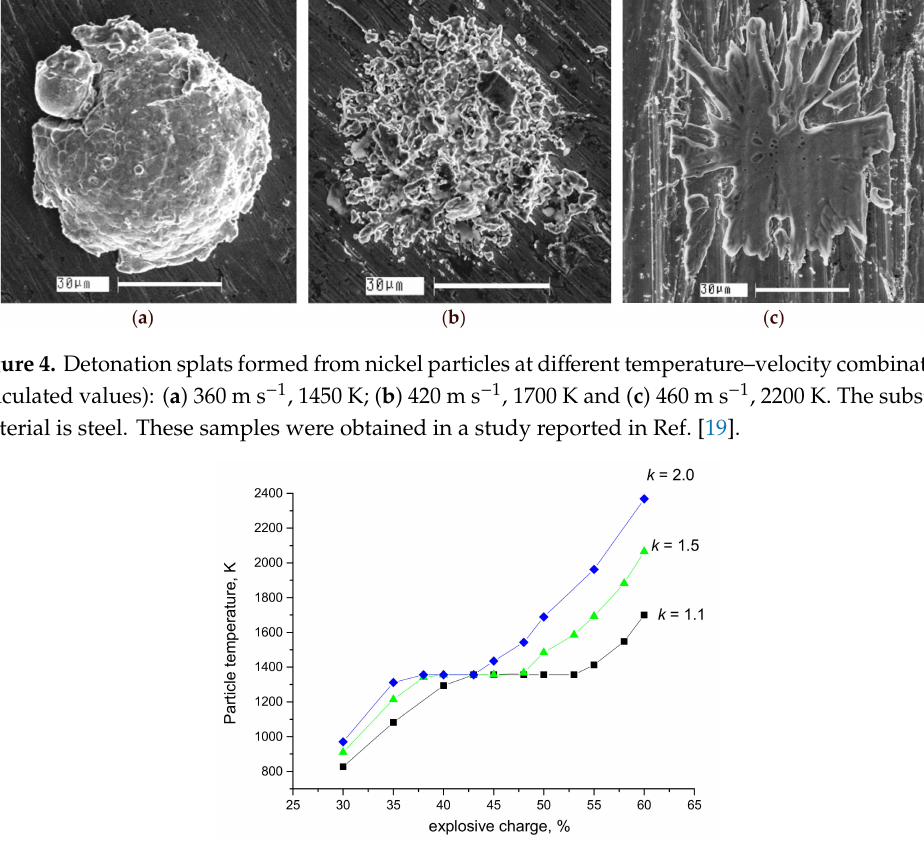
Figure 5. Calculated temperatures of copper particles 40 µ m in size exiting the barrel of the detonation gun sprayed with di ff erent explosive charges using nitrogen as a carrier gases and k equal to 1.1, 1.5 and 2 (barrel length 1000 mm, barrel diameter 20 mm).